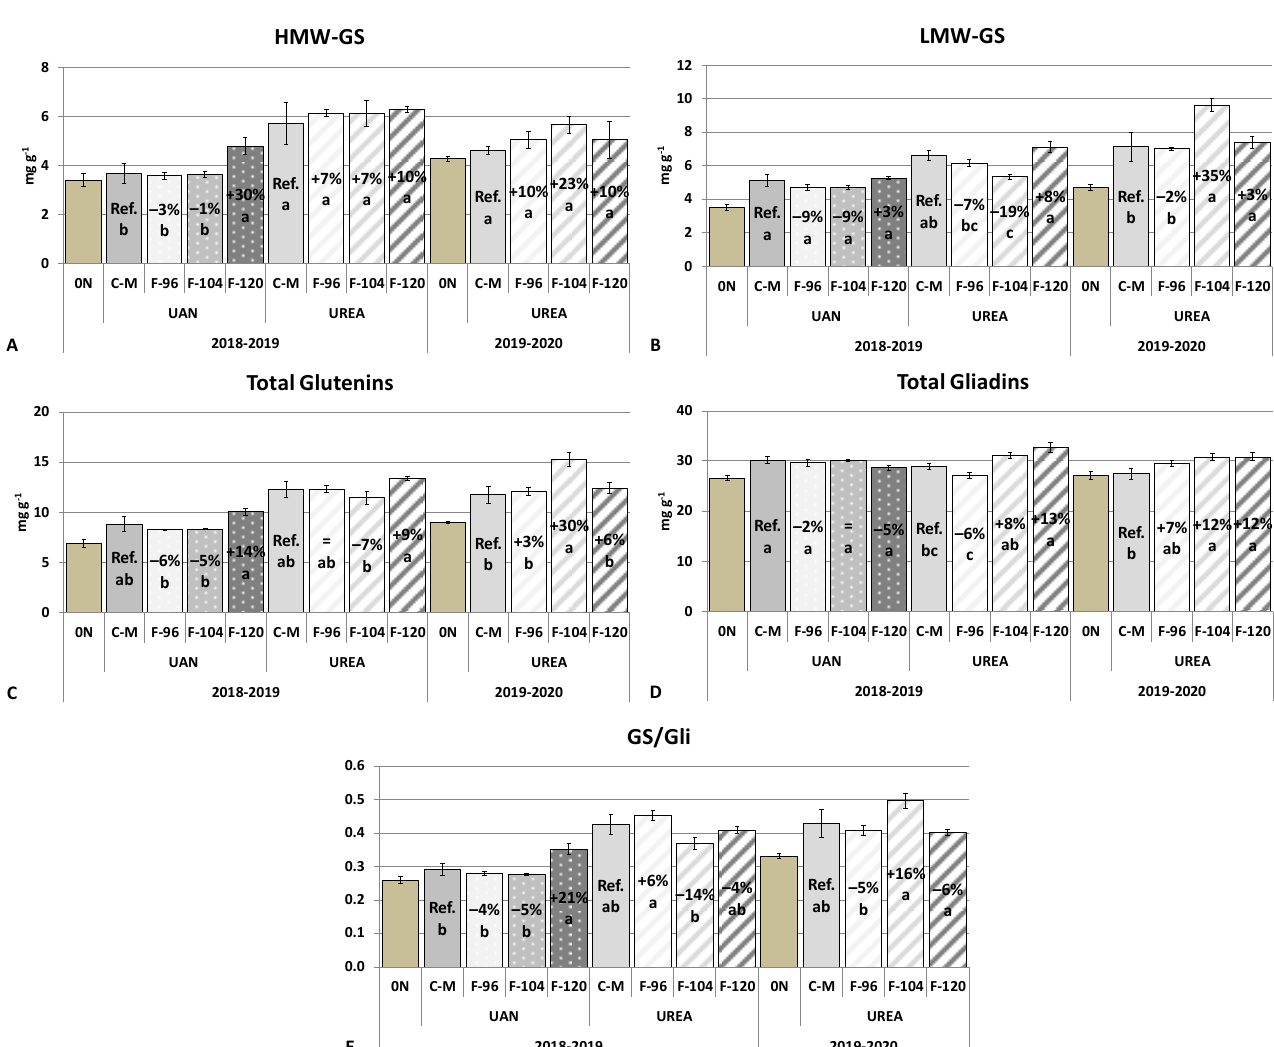
Figure 2. High-molecular-weight glutenins (HMW-GS) ( A ), low-molecular-weight glutenins (LMW-GS) ( B ), total glutenins ( C ), total gliadins ( D ) and gliadins-to-glutenins ratio ( E ) (mg g − 1 ± S.E.; n = 3) in wheat grains under different foliar N fertilization treatments in a two-year field trial with UAN and urea as fertilizers. Percentages: variation vs. each conventional management C-M (Ref.). Letters: statistical comparisons among treatments within the same fertilizer (Newman–Keuls test, p ≤ 0.05).